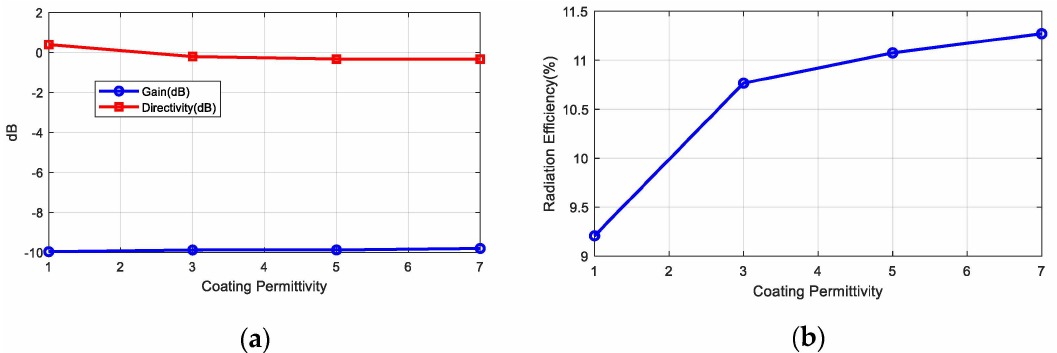
Figure 10. ( a ) Simulated gain and directivity at θ = 0 ◦ , φ = 0 ◦ and ( b ) radiation e ffi ciency as a function of the coating permittivity (1–mm thick coating thickness) at 406